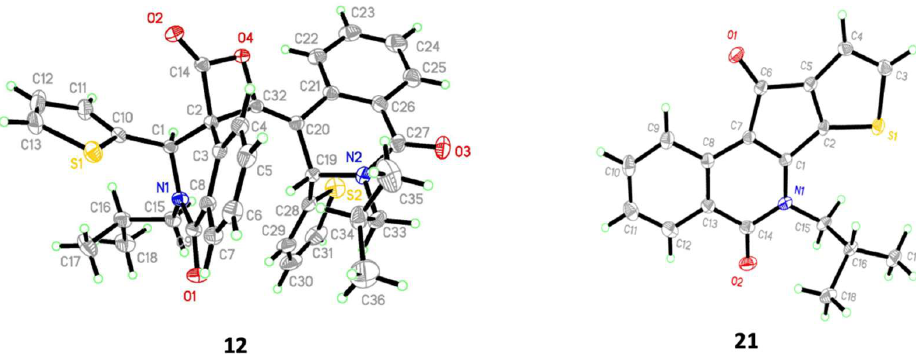
Figure 2. ORTEP representations of the major lactone product ( 12 ) and the purple ketone product ( 21 ). Table 1. Products from the reaction of cis THIQ carboxylic acid 4 with T3P. NMR yields are based on H-1 NMR analysis with cis -stilbene as the internal integration standard.